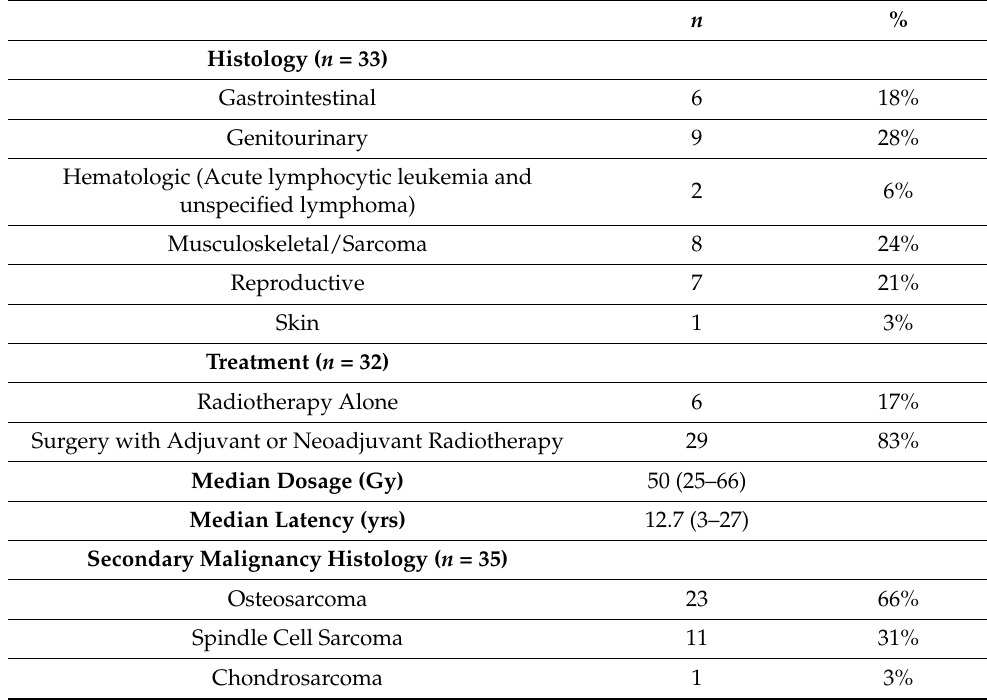
Table 1. Descriptive characteristics of the original cancer diagnosis and treatment, with presenting details on the subsequent histology, for patients with radiation-associated sarcoma of the pelvis and